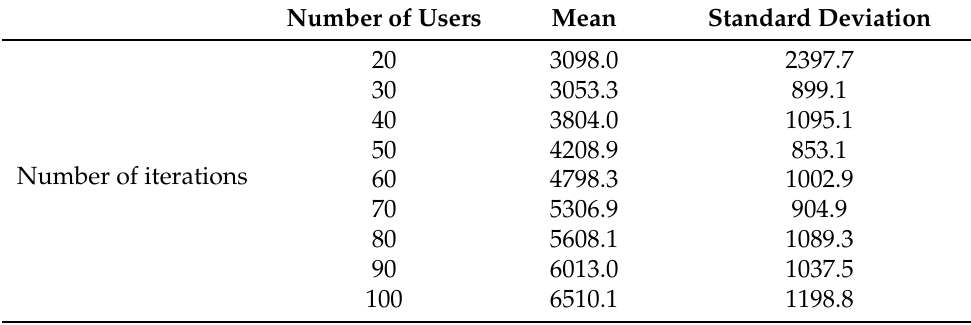
Table 3. Including standard deviation in the average time to